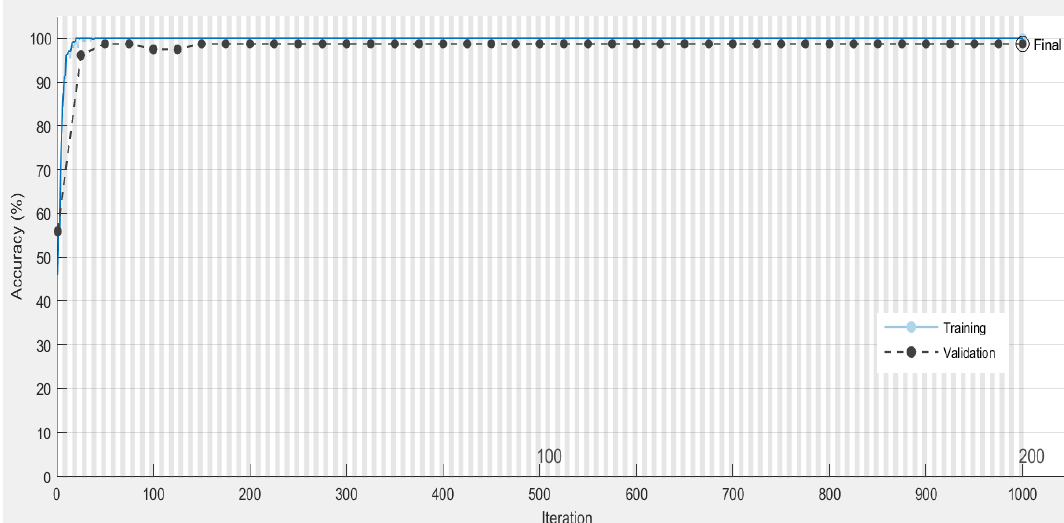
Figure 11. Plots of accuracy versus the number of iterations obtained using the BLSTM classifier with hold-out CV for the automated classification of the BFMAC vs. DMAC